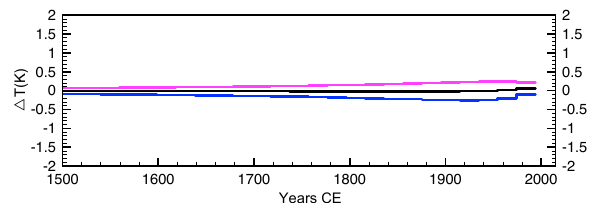
Figure 5. GST history for northern coastal Chile (Michilla) deter- mined for its period of measurement (1994) from the simultaneous inversion of na12, p398, and z197, where three eigenvalues are re- tained. The pink and blue lines represent the inversion of the upper and lower bounds of the temperature anomaly or the extremal steady states.